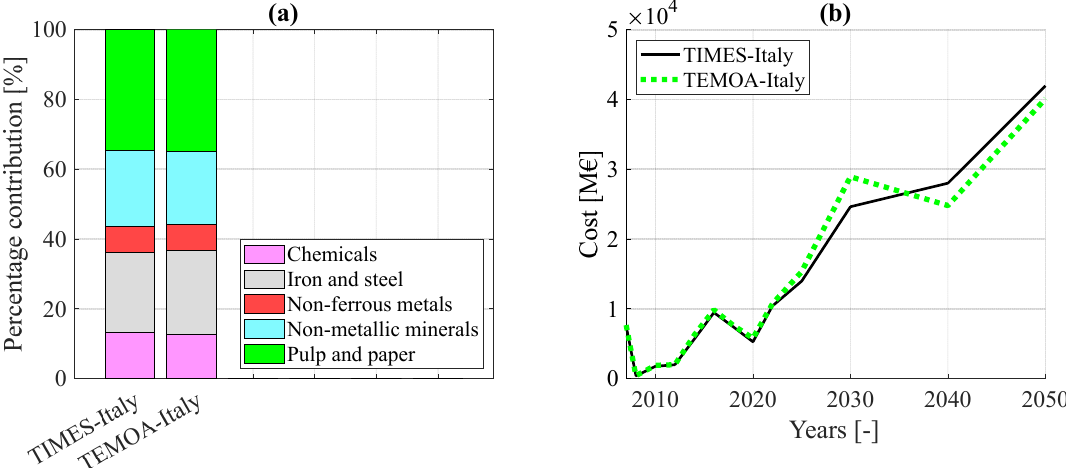
Figure 8. Comparison between the cumulative total cost of the industrial sector: ( a ) percentage sub-sectorial contributions; ( b ) evolution in time.